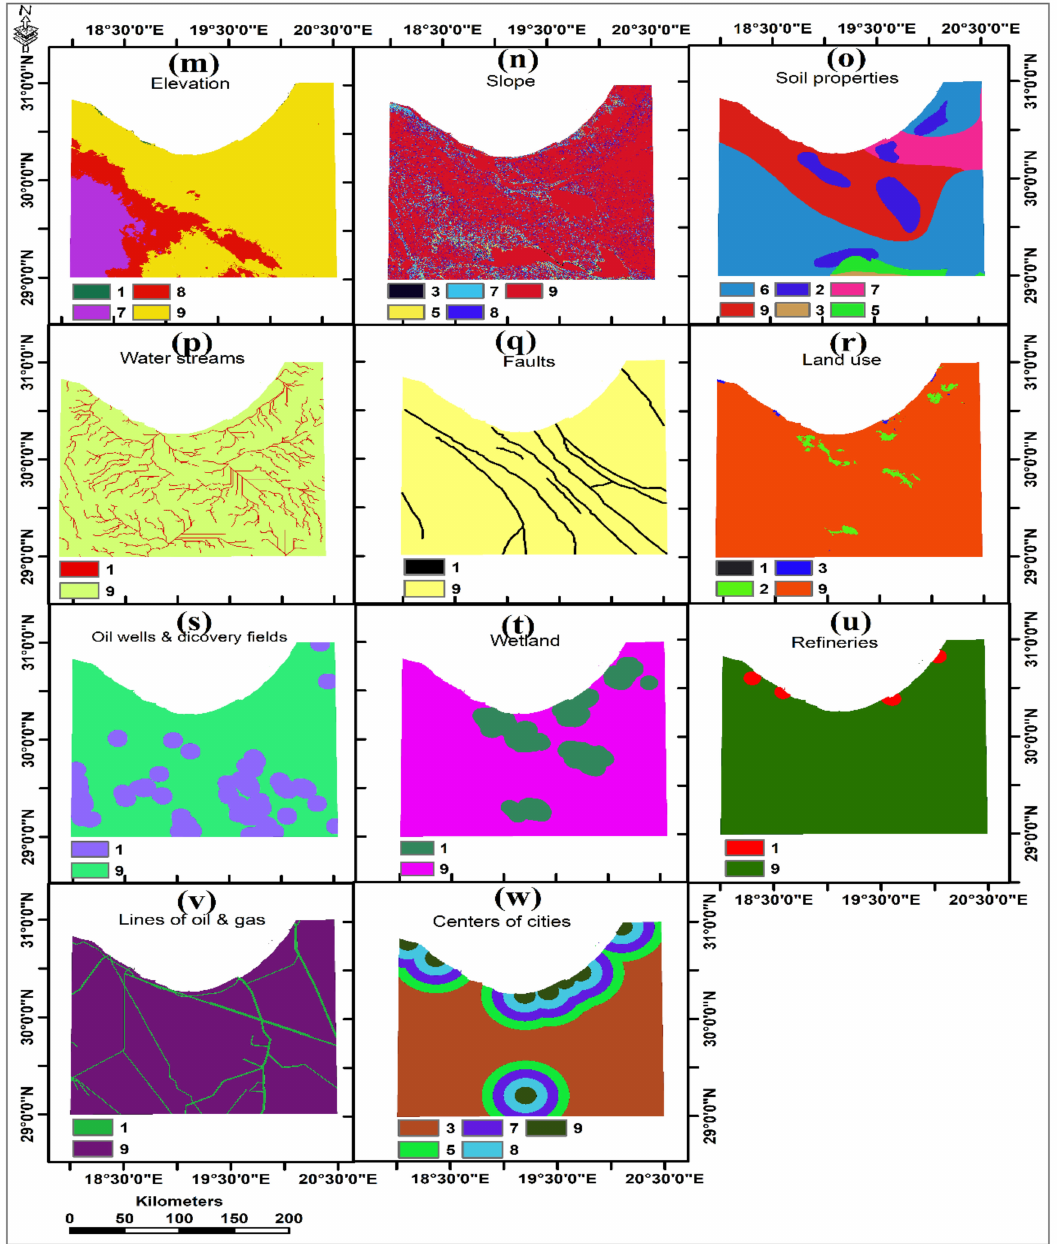
Figure 6. Classes determined for ( a ) communication stations; ( b ) water resources; ( c ) power lines; ( d )landcover; ( e )residentialregion; ( f )roads; ( g )atmosphericpressure; ( h )temperature; ( i )precipitation; ( j ) wind; ( k ) clearness; ( l ) relative humidity; ( m ) elevation; ( n ) slope; ( o ) soil properties; ( p ) water streams; ( q ) faults; ( r ) land use; ( s ) oil wells and discovery fields; ( t ) wetlands; ( u ) refineries; ( v ) lines of oil and gas; ( w ) centers of